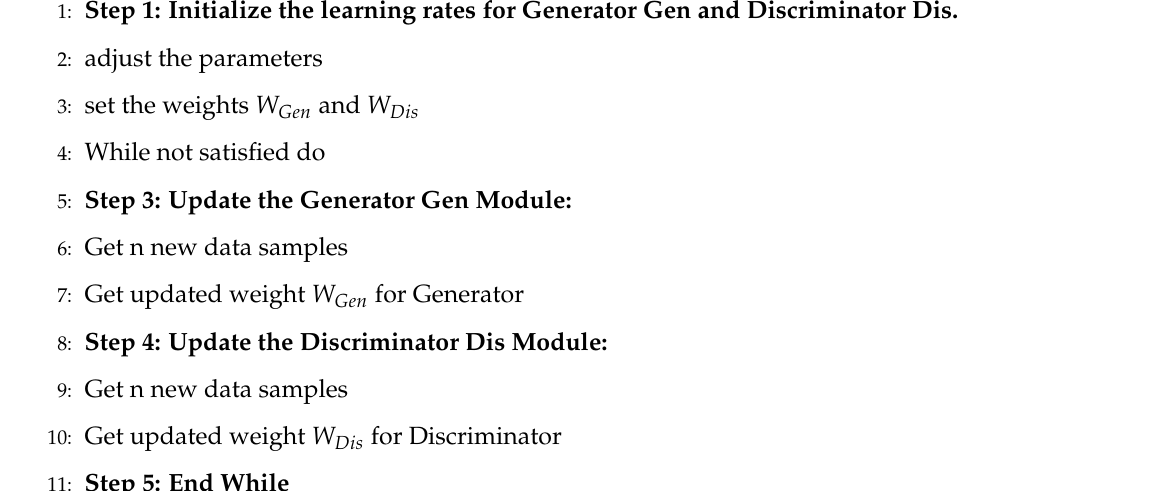
Algorithm 2 Pseudo-code for the training of Generator and